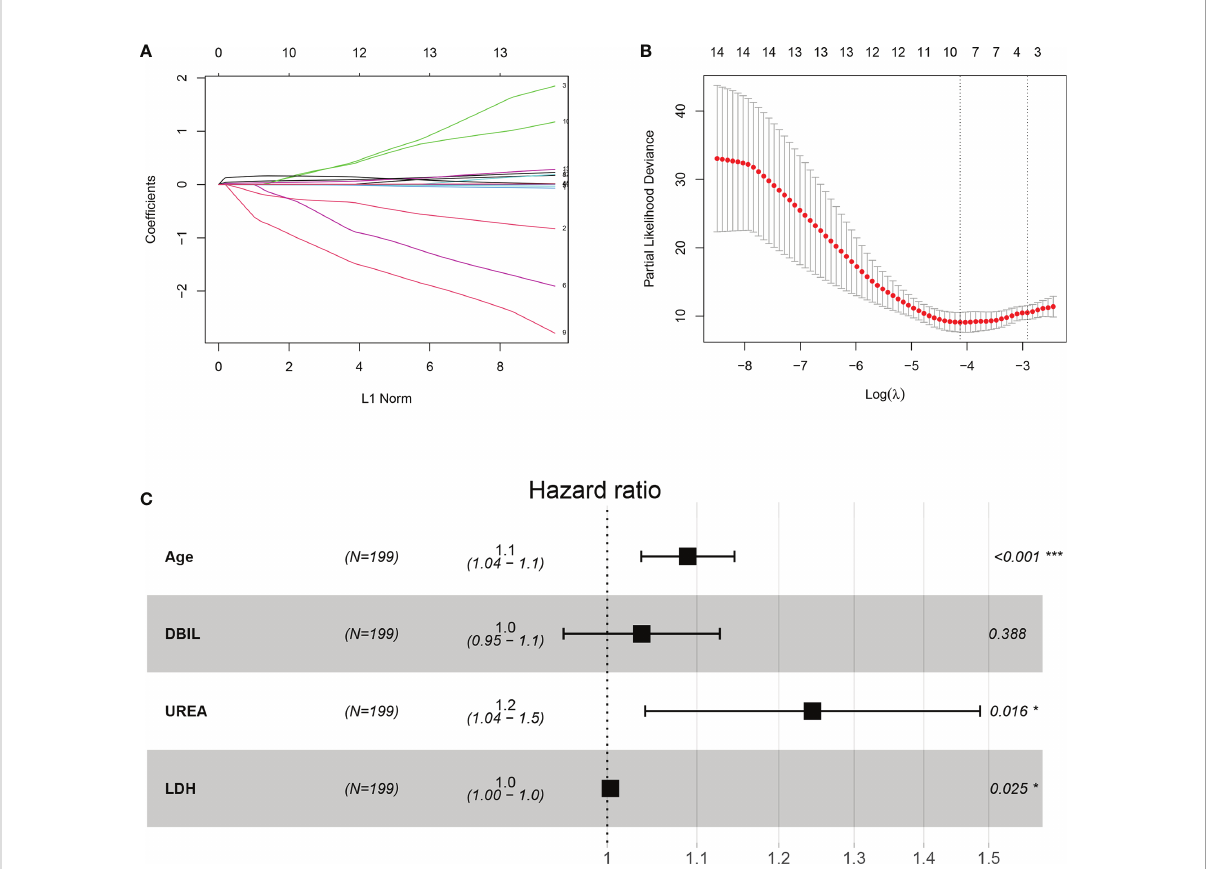
FIGURE 2 Construction of the integrated prognostic features of patients with COVID-19. (A) LASSO coef fi cient pro fi les of the 21 prognostic features. (B) Selection of the tuning parameter (lambda) in the LASSO model by fi vefold cross-validation based on minimum criteria for prognosis; the lower X-axis shows log (lambda), and the upper X-axis shows the average number of prognostic features. The Y-axis indicates the partial likelihood deviance error. Red dots represent average partial likelihood deviances for every model with a given lambda, and vertical bars indicate the upper and lower values of the partial likelihood deviance errors. The vertical gray dotted lines de fi ne the optimal values of lambda, which provides the best fi t. (C) Forest plots of multivariate Cox regression analysis for 80-day survival of patients with COVID-19. DBIL, direct bilirubin; LDH, lactate